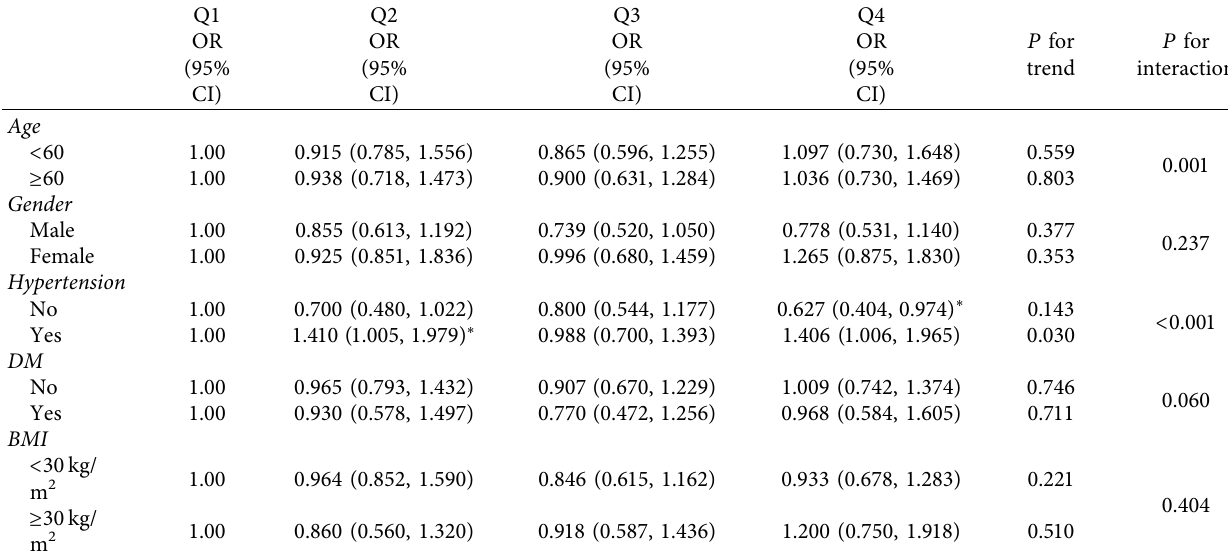
Table 4: Subgroups analysis for the associations of serum 25(OH)D with the prevalence of